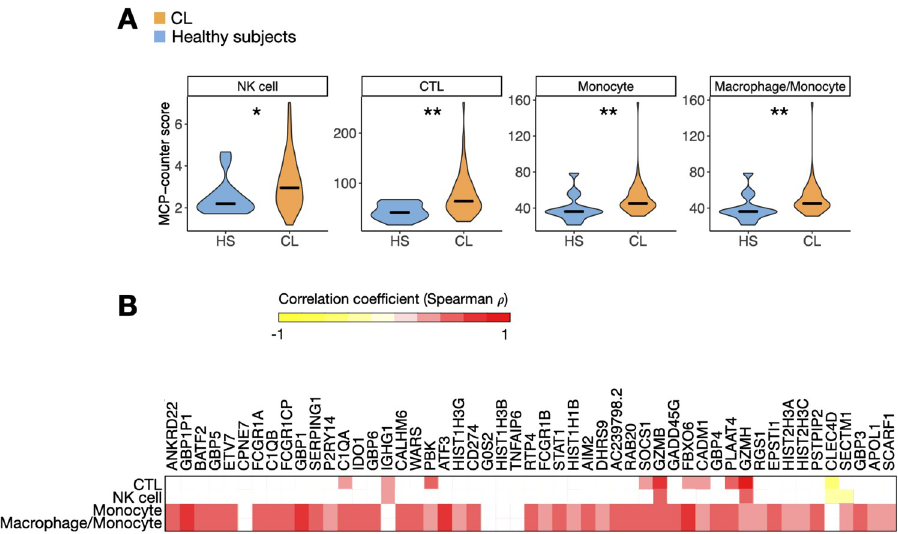
Fig 4. Peripheral blood cytotoxicity and ISG signatures are associated with CTL/NK cells and monocytes/ monocyte-like macrophages, respectively. (A) Median of MCP-counter abundance scores for cell types that were differentially enriched between CL patients and HS. NK cells, cytotoxic lymphocytes (CTL), monocytes and macrophage/monocytes were differentially enriched by Wilcoxon rank-sum test, P < 0.05. (B) A correlation matrix between the MCP-counter abundance scores and the expression of the 51 genes overexpressed in the blood of CL patient samples, in log2 CPM. Spearman’s rho ( ρ ) correlation coefficient ranges from 1 (red) to -1 (yellow). Correlations where P < 0.05 are not represented in the plot (blank